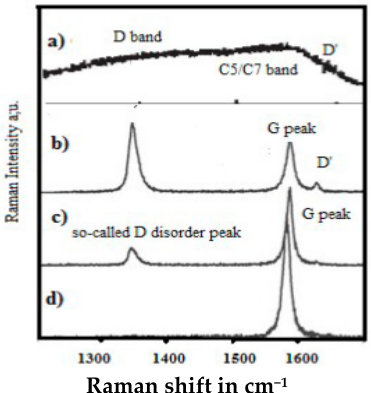
Figure 8. Relation between graphene void defects produced by Ar ion bombardment and so-called D disorder carbon Raman peak. By M.S. Dresselhaus et al. [170] with permission of Phil. Trans. R. Soc. A. ( a ) With Ion dose >10 15 destruction of hexagonal ring. Disorder band broadening, with ~30 cm − 1 stress shift. The broad “G” band corresponds to the upshifted band of C5/C7 odd rings. ( b ) D’ peak suggested to be assigned to dangling Csp2-Csp2 formed on internal void edges. ( c ) For ion dose 10 11 the G peak is stress upshifted, without disorder band broadening, suggesting few incorporated vacancies. ( d ) Pristine graphene is an ordered structure (one sharp G peak).